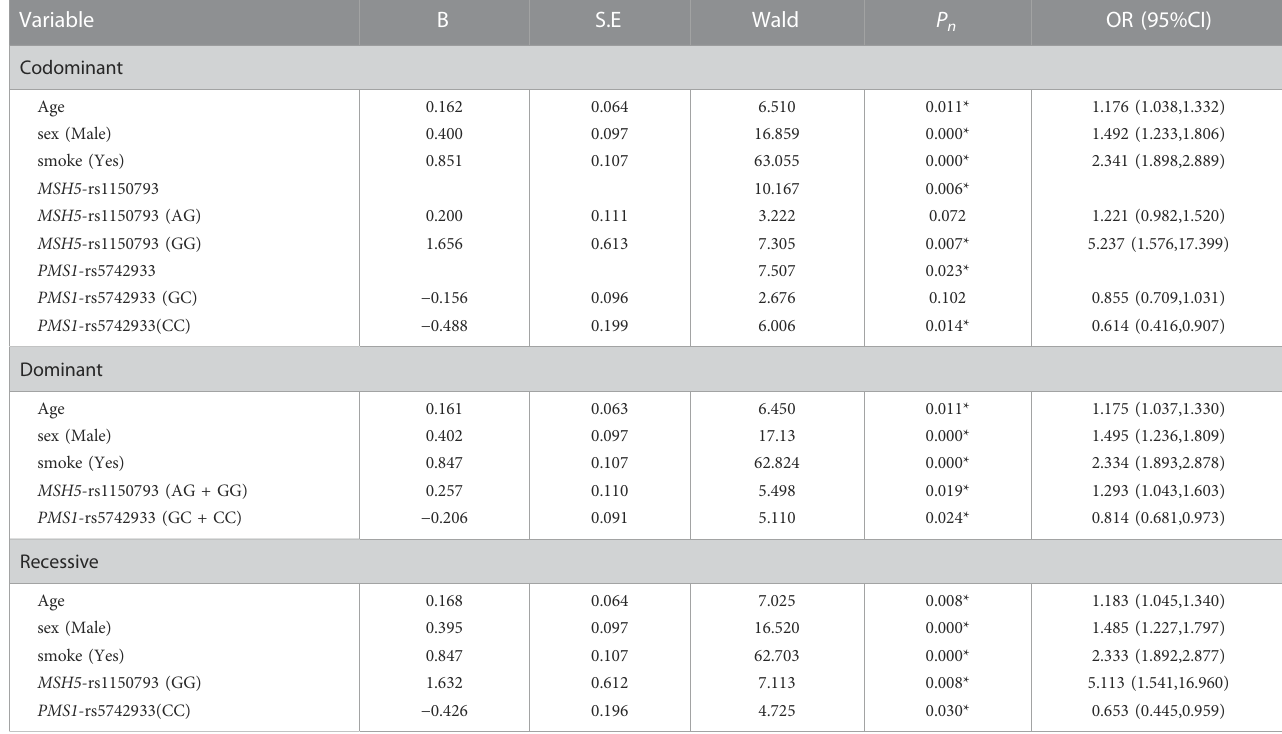
TABLE 1 The multivariate Logistic Regression analysis of predictive factors for HBV susceptibility under three models in NeC vs. HLD group.